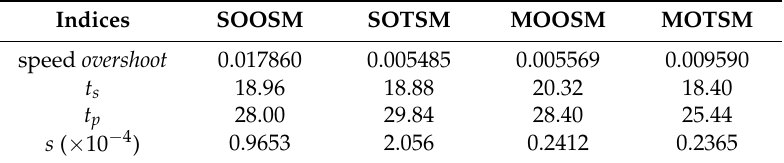
Table 6. The performance